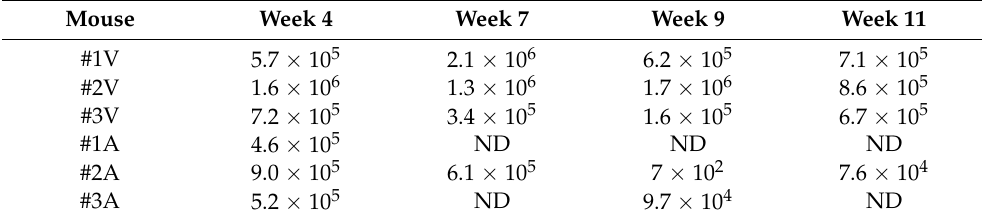
Table 2. Viral DNA copy numbers in vaginal (V) and anal (A) tracts of three mice infected with